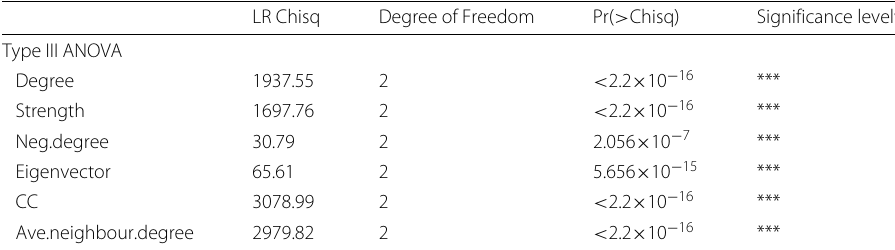
Table 6 Type III ANOVA test on likelihood-Ratio chi-square test and p -value test LR Chisq Degree of Freedom Pr( > Chisq) Significance level a Type III ANOVA Degree 1937.55 2 < 2.2 × 10 − 16 *** Strength 1697.76 2 < 2.2 × 10 − 16 *** Neg.degree 30.79 2 2.056 × 10 − 7 Eigenvector 65.61 3078.99 2979.82